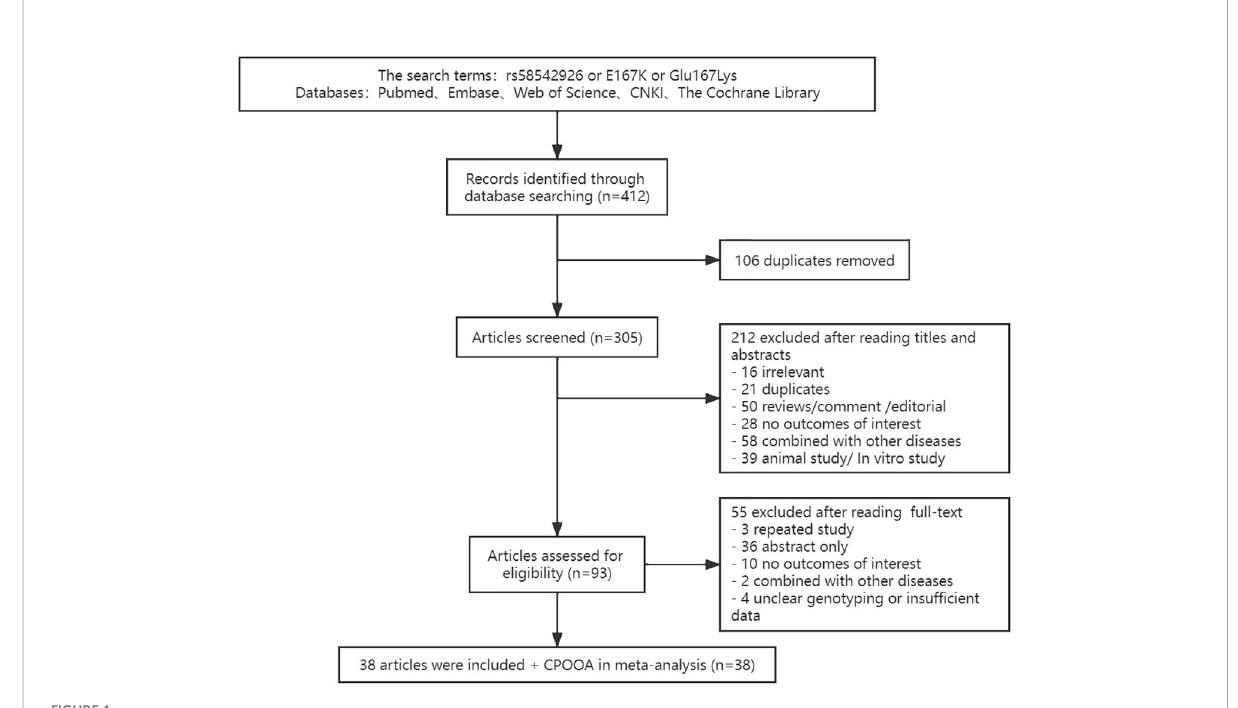
FIGURE 1 Flowchart of study